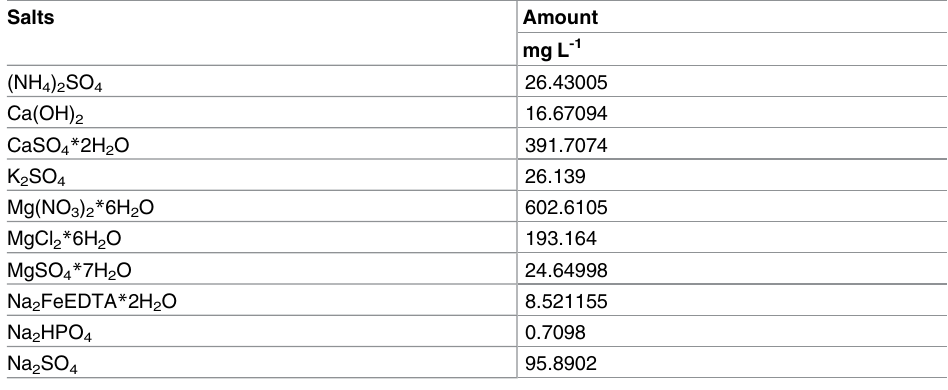
Table 6. Recipe generated by ARS-Media for Excel to recreatethe soil solution ion composition of Angle et al.